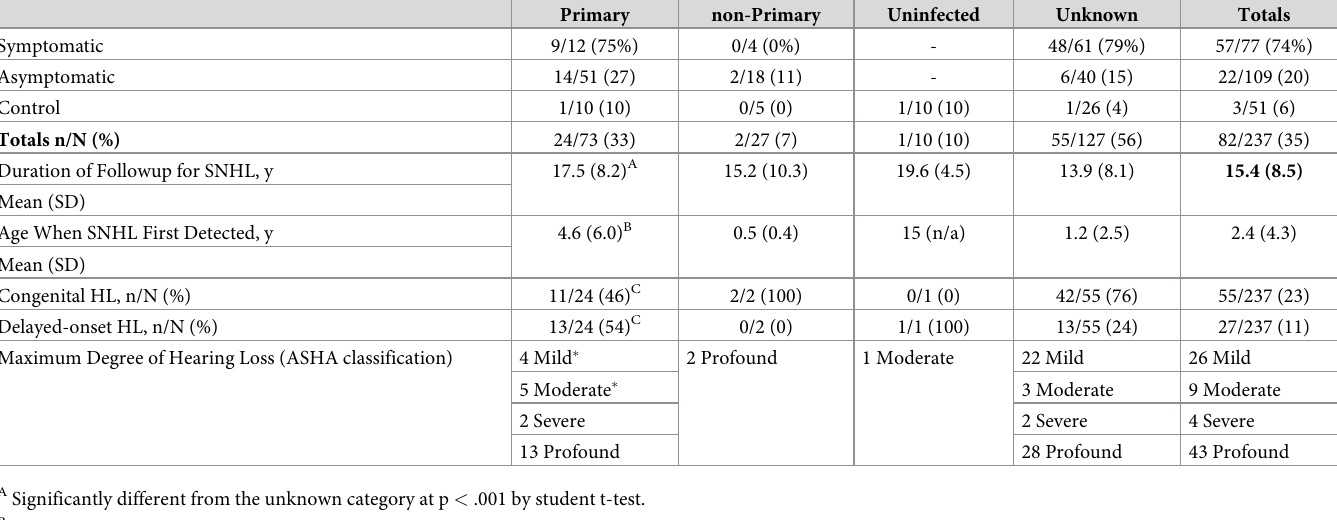
Table 2. Symptom status and sensorineural hearing loss by maternal CMV infection